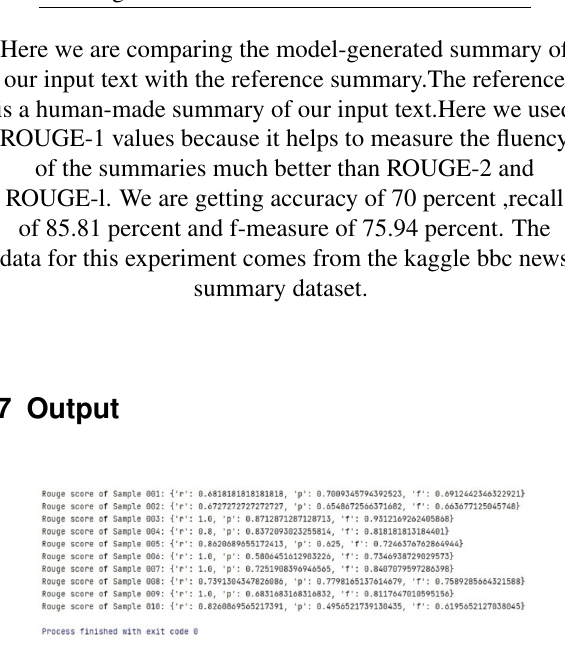
Figure 4. ROUGE-1 scores of the sample dataset